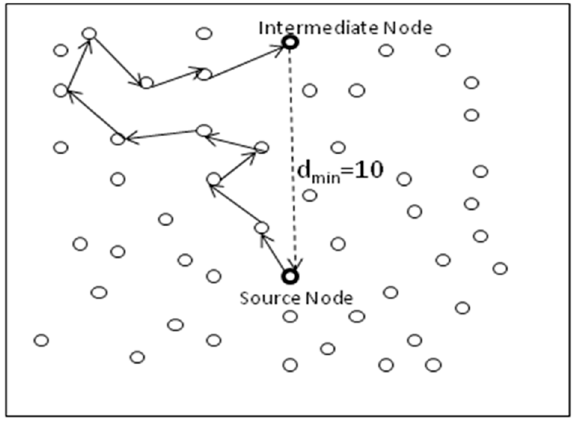
Figure 5. Showing d min from source to intermediate node.